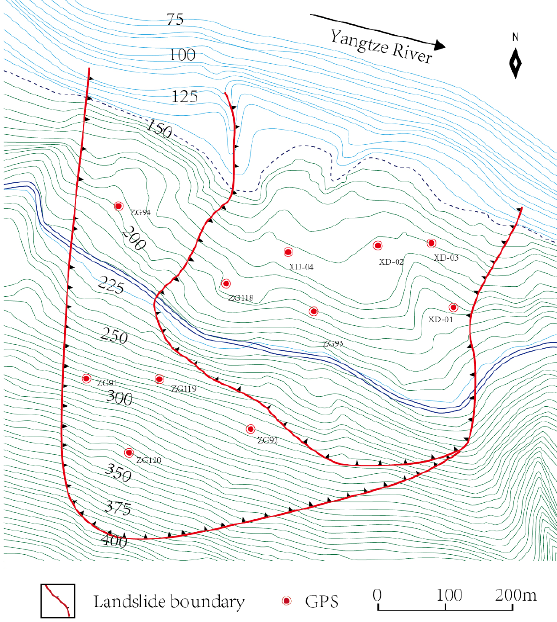
Figure 5. The topographic map of the Baishuihe landslide .